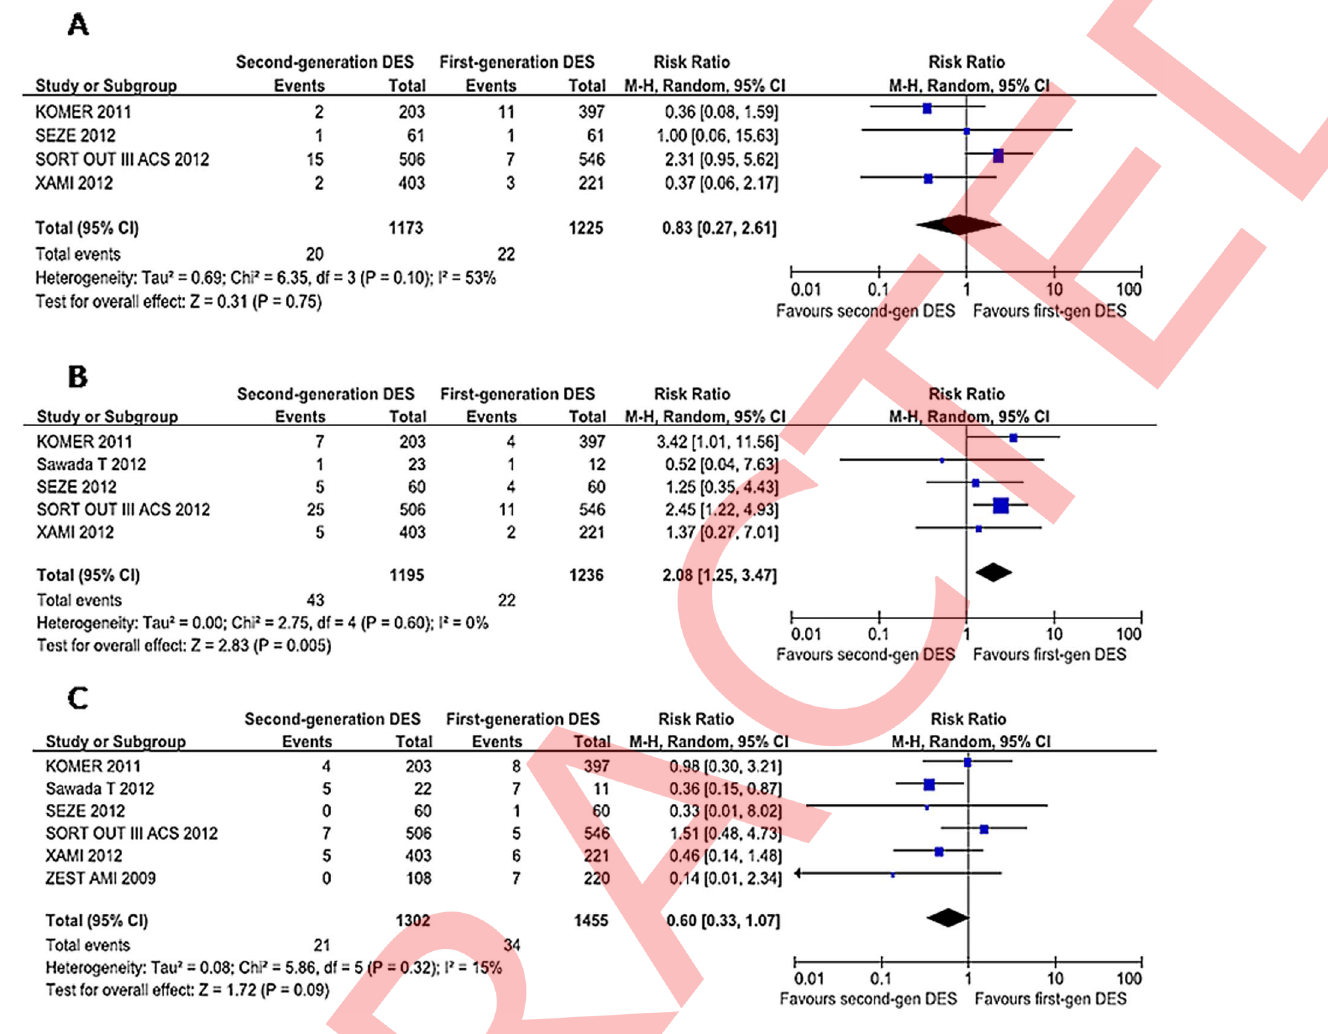
Figure 3. Pooled risk ratios of second-generation versus first-generation drug-eluting stents for acute coronary syndrome for recurrent myocardial infarction (A), target lesion revascularization (B), and definite or probable stent thrombosis (C). Abbreviations as Figure 2.